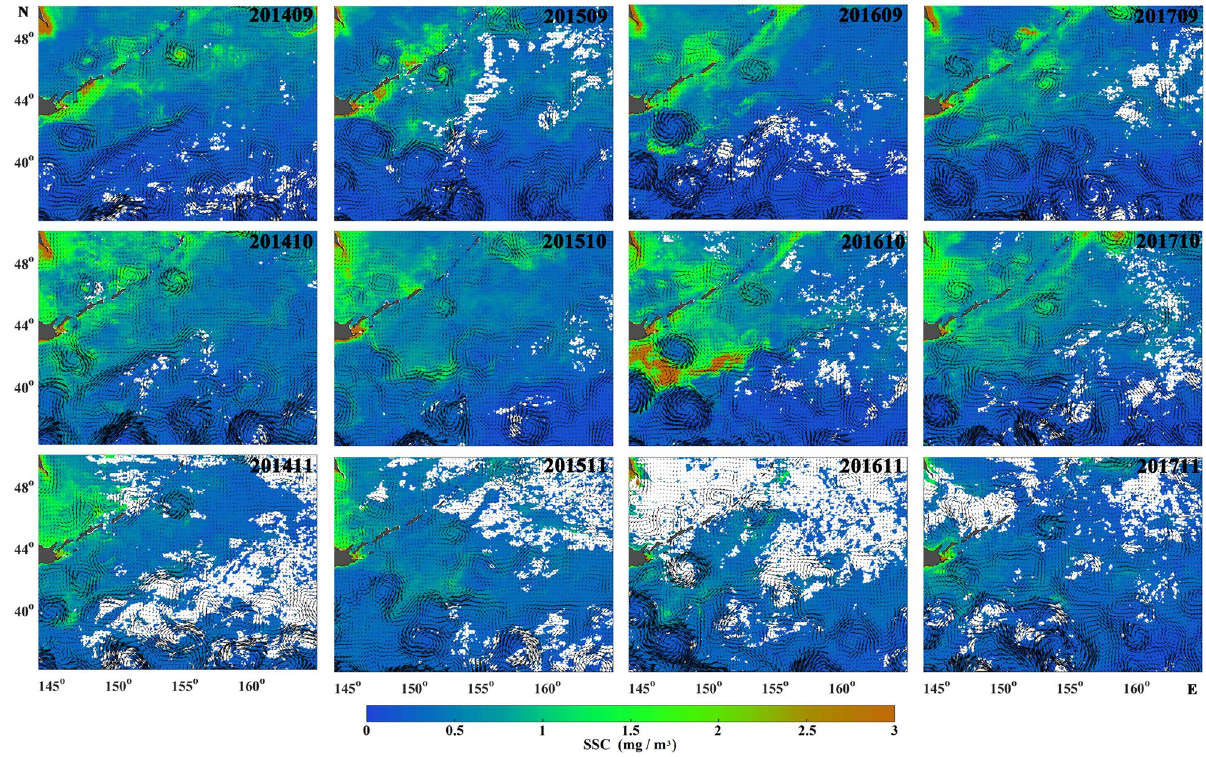
Figure 10. Relationships between SSC and geostrophic currents in September–November between 2014 and 2017. Maps were created using MATLAB R2016a sofware by MathWorks (https:// ww2. mathw orks. cn/ produ cts/ matlab.